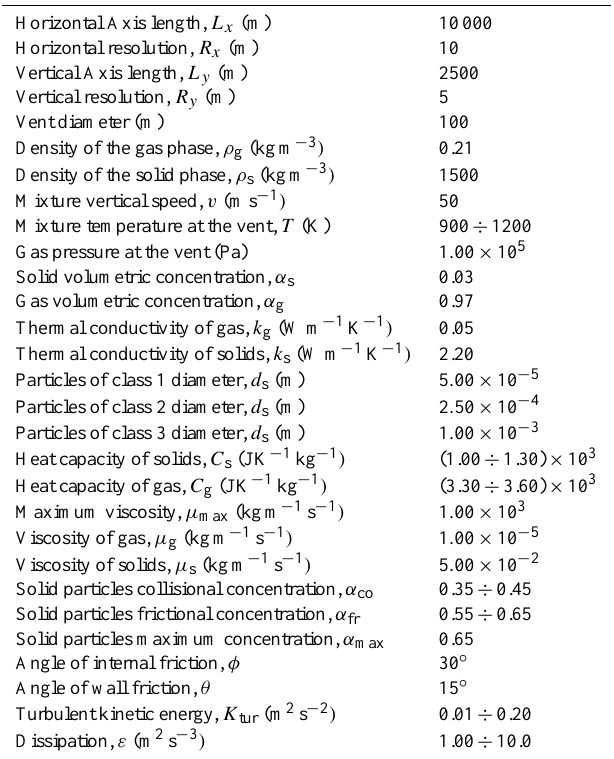
Table 1. Boundary and initial conditions used for numerical simu-